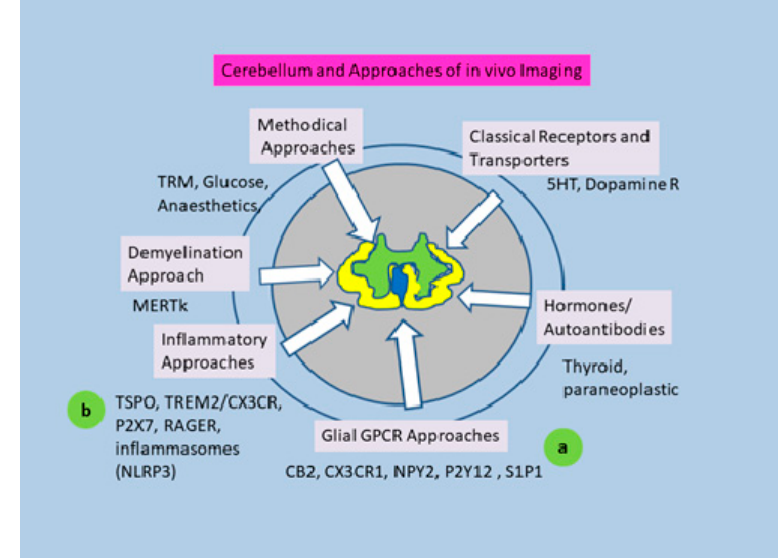
Figure 1. Approaches to cerebellar in vivo imaging reflected by the literature through the last decade. Early approaches concerned metabolic imaging using [ 18 F] fluorodeoxyglucose (FDG) or 15 O, supplemented more recently by respective magnet resonance imaging methods providing increasingly detailed functional and higher anatomic resolution. Classical neuronal receptors visualized also in the cerebellum included, for example, 5 hydroxytryptamine, dopamine, opioid and adenosine receptors. The present contribution is focused on: ( a ) glial G protein-coupled receptor (GPCR) approaches: G-protein-coupled receptors known for inflammation triggered overexpression in microglia and potential small molecule ligands suitable for PET visualization of the receptors; ( b ) inflammatory approaches: the chemokine receptor, the ionotropic receptor and the immune receptors RAGE and TREM2 with influence on the formation of inflammasomes and the current possibilities of visualization with PET. CB2: cannabinoid receptor 2; CX3CR1: chemokine receptor CX3C 1; NPY2: neuropeptide Y receptor 2; MERTK: myeloid-epithelial reproductive tyrosine kinase; 5-HT: 5-hydroxytryptamine; P2Y12: purinoceptor Y12; P2X7: purinoceptor 2X7; S1P1: sphingosine 1 phosphate receptor 1; RAGE: receptor of advanced glycation end products; TREM2: triggering receptor expressed on myeloid cells 2; TSPO: translocator protein 18 kDa.